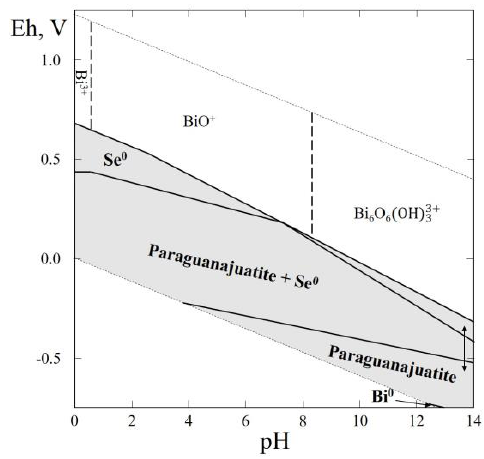
Figure 11. Eh-pH diagram of the OHSeBi (Bi-Se-H 2 O) system at 25 °C and the activities of the components: a ΣSe = 10 − 4 , a ΣBi = 10 − 5 . The dotted lines are the boundaries between fields of Bi 3+ , BiO + and Bi 6 O 6 (OH) 33+ .